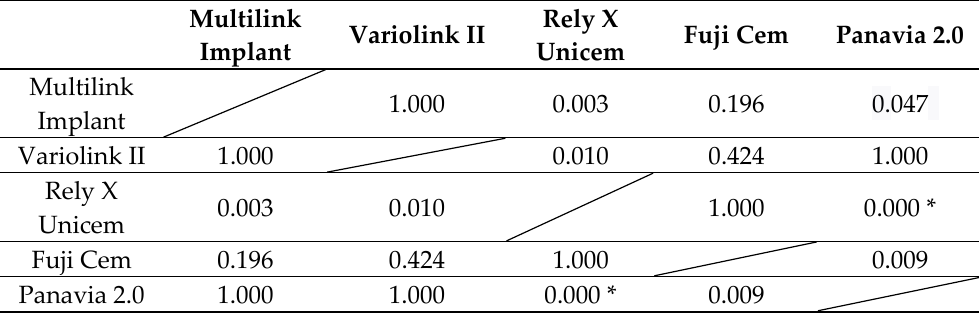
Table A3. Comparison of the different adhesives during the pull-off test: Ivoclar e.max CAD.